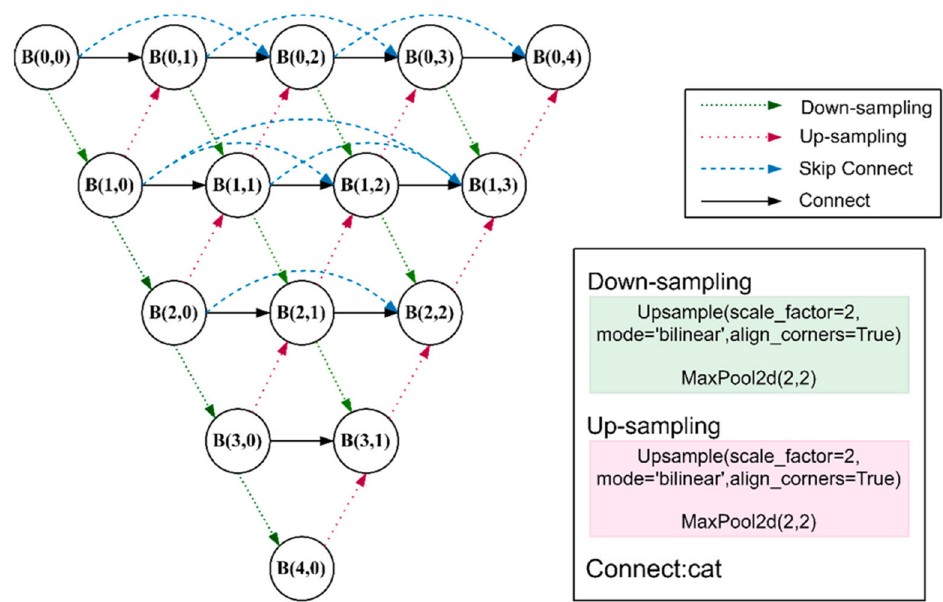
Figure 4. The figure shows a schematic diagram of DRUNet; each node is ECA-Rest Block. The legend on the top right indicates the operations of the different shapes and colors of lines in the structure graph, and the legend on the bottom right indicates the functions and parameters corresponding to these operations. The operations of skip connect and connect are both cat, linking the feature map in the first dimension of the feature map; for example, the shape of feature map A is (batch size, channels_1,H,W), the shape of B is (batch size, channels_2,H,W), and the size of the feature map after connection is (batch size, channels_1+channels_2,H,W).